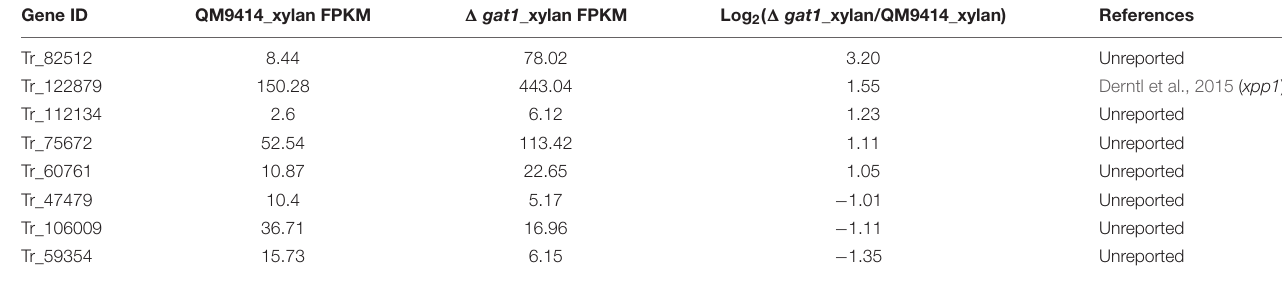
TABLE 5 | Transcription factor encoding genes with differential expression between (cid:49) gat1 and QM9414 on